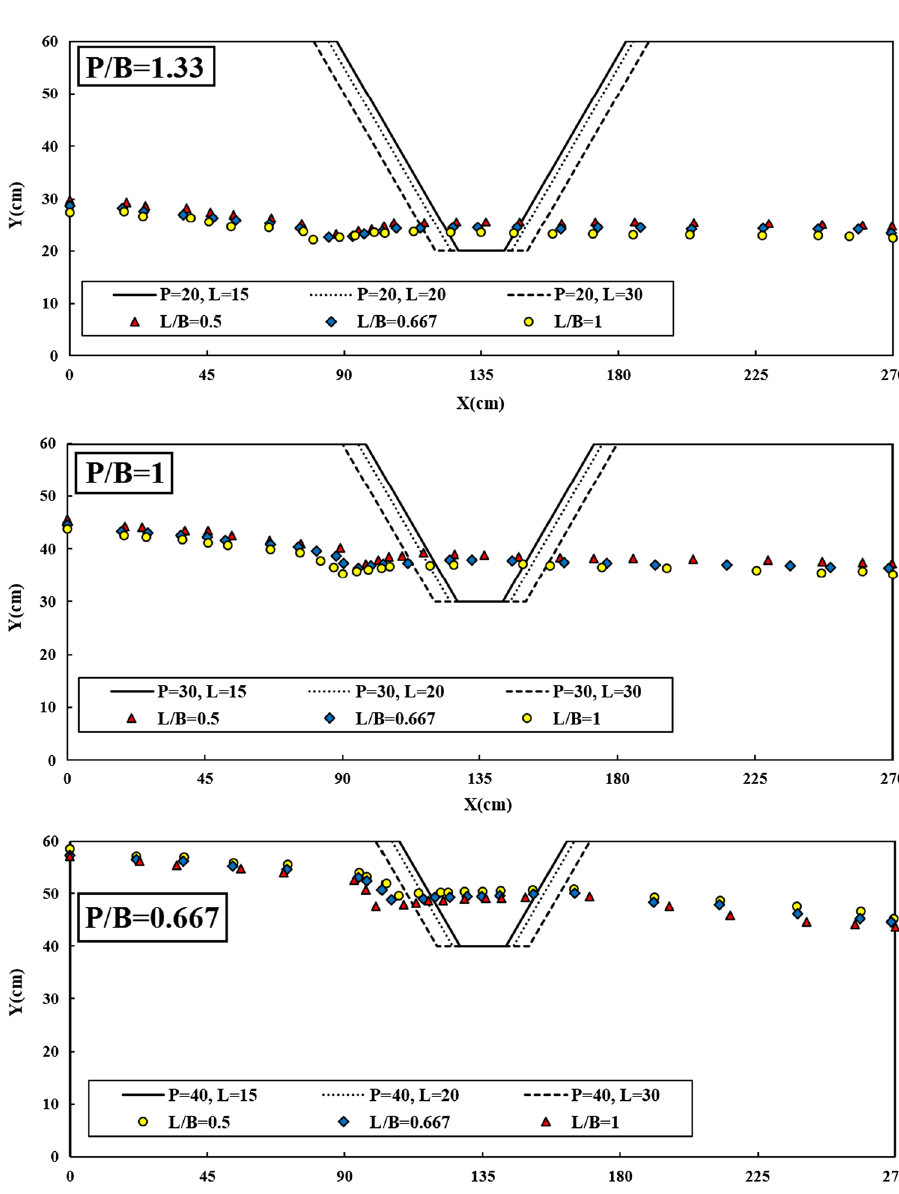
Fig. 5 Free surface profile of flow passing over a TSCSW ( P / B = 1.33, 1 and